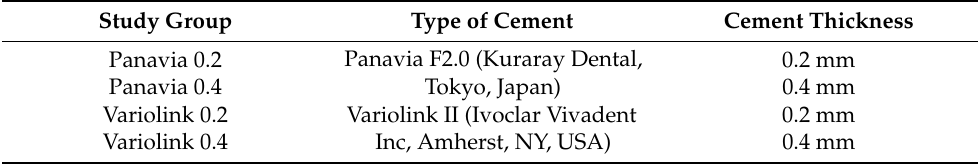
Table 2. Study groups.